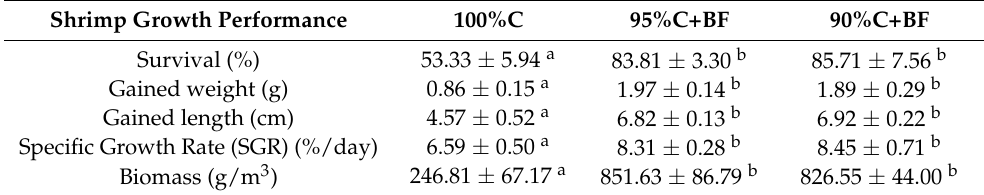
Table 2. Shrimp growth performance with and without supplementation of ex-situ bioflocs (100%C) and with different feeding regimes in which 95%C+BF were shrimp fed with 5% ( w / w ) feed reduction supplemented with 0.3% ( v / v ) biofloc, and 90%C+BF were shrimp fed with 10% ( w / w ) feed reduc- tion supplemented with 0.3% ( v / v ) biofloc. Different letters above the values indicate significant differences among the treatments ( p <